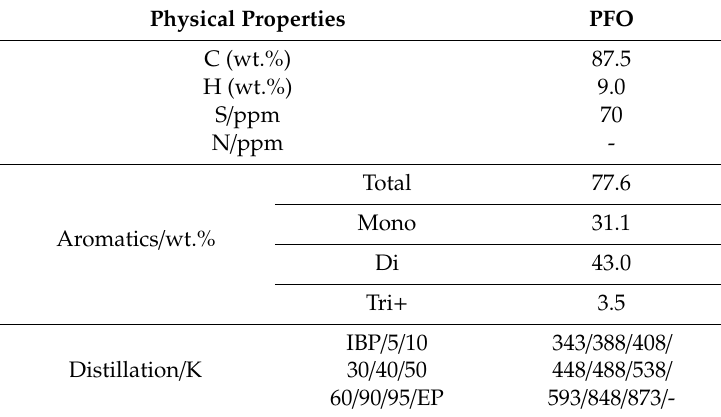
Table 3. The composition of pyrolysis fuel oil